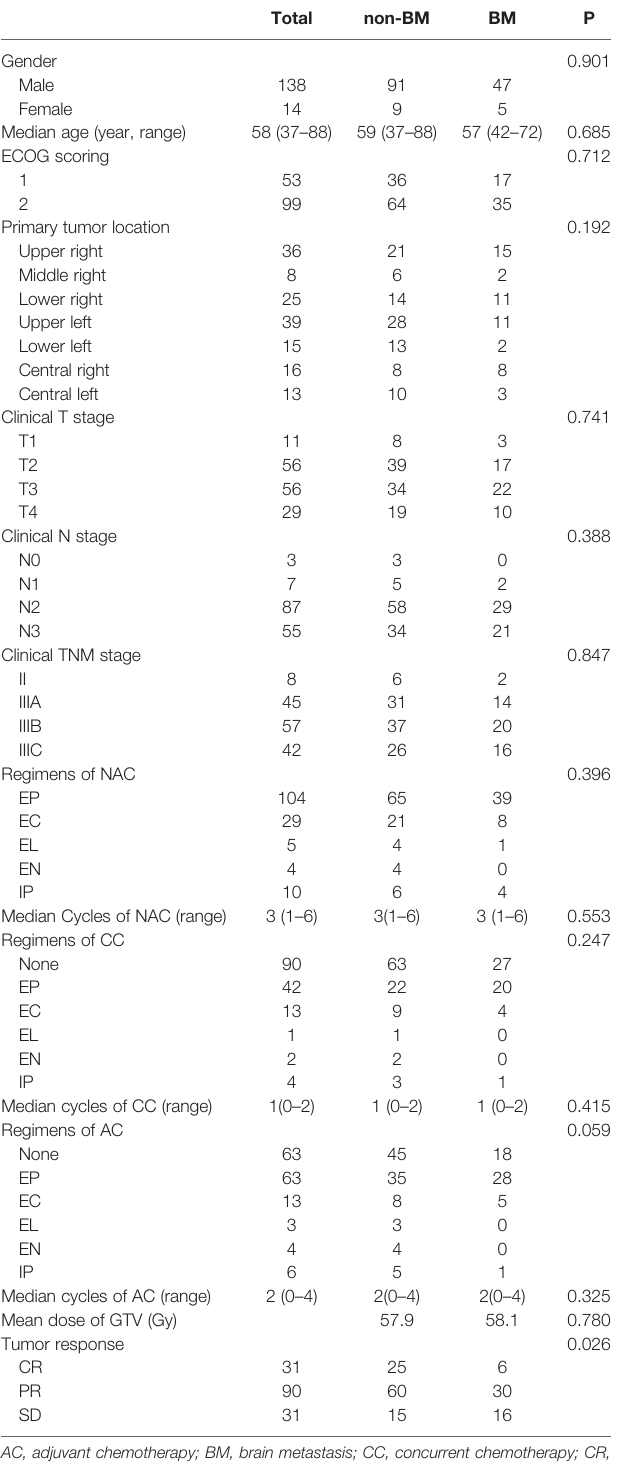
TABLE 1 | Clinical characteristics of